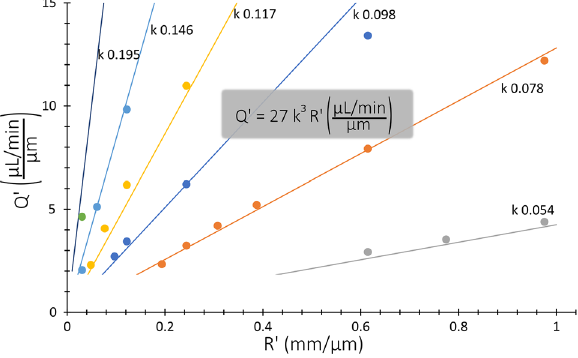
Figure 7. Analytical expression for Q ′ max (Eq. 6, straight lines) together with experimental data (dots) from the first set (41 × 84 µm ( WxH )) for different k values ( k